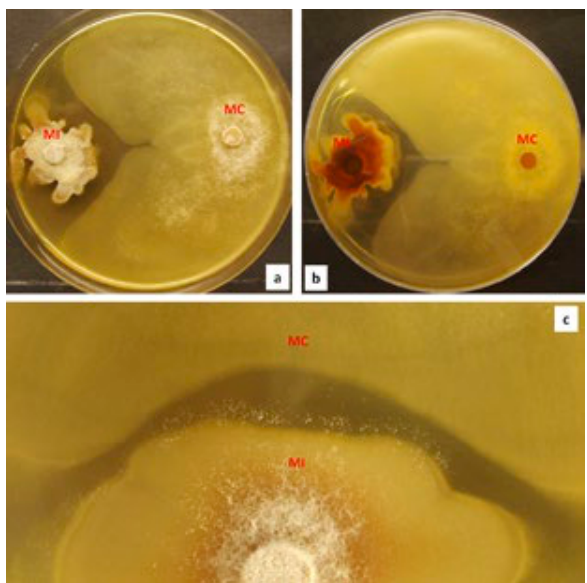
Figure 5. Compatibility trial 21 d after inoculation of Jug- lans regia with Geosmithia morbida monoconidial isolates MC and MI obtained from isolate 11 (representative of the compatible strains) and isolate 7 (representative of the in - compatible strains). a, front plate; b, reverse; c, detail of